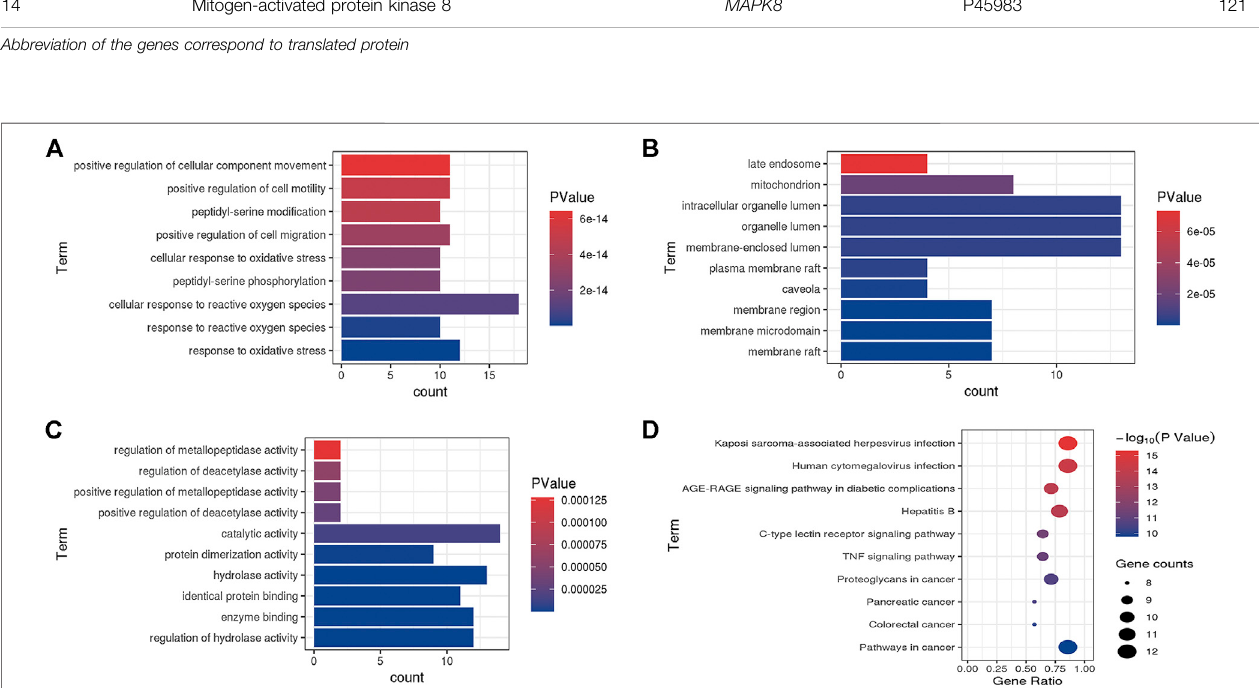
Frontiers in Pharmacology |